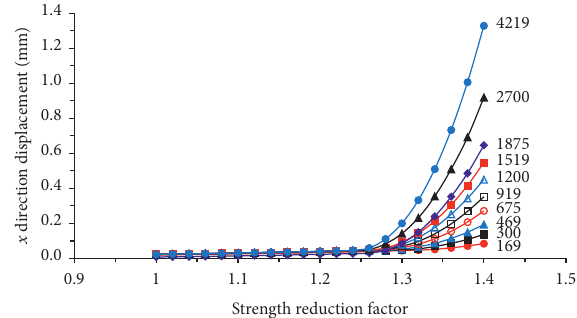
Figure 5: The curves of horizontal displacement versus the SRF with different element